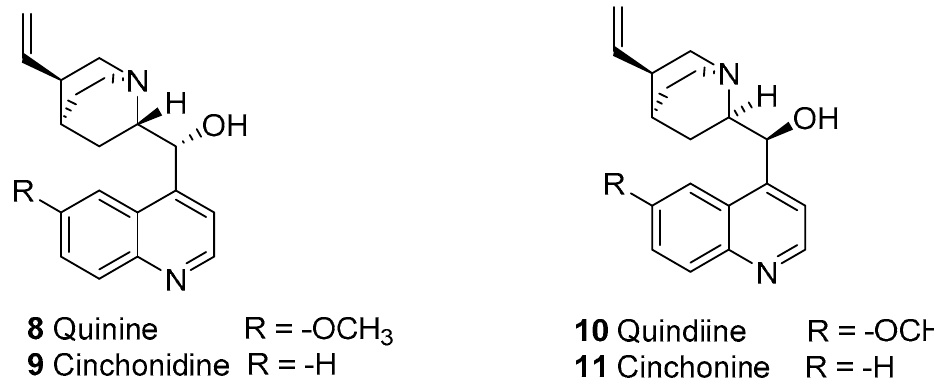
Figure 6. Major Cinchona alkaloids. Quinine and quinidine are included on WHO list of essential medicines (https://www.who.int/medicines/publications/essentialmedicines/en/ine, accessed April 2021).